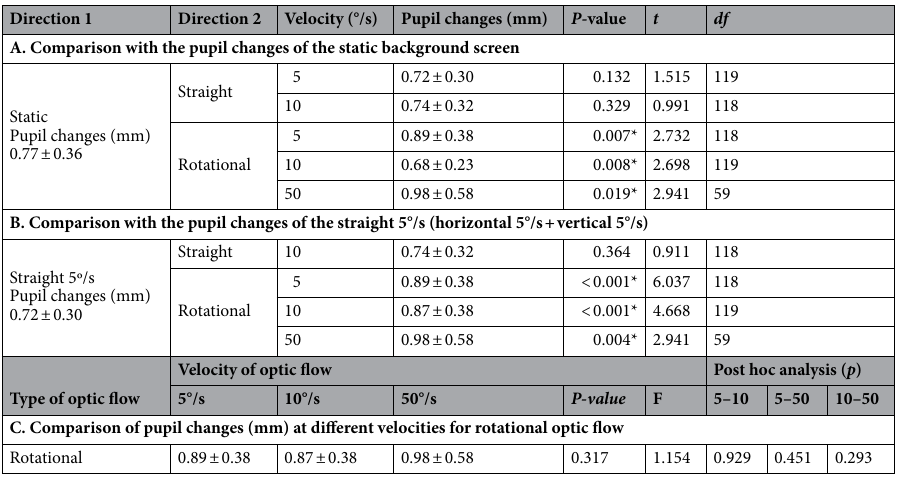
Table 2. Comparison of the pupil changes of each experimental optic flow